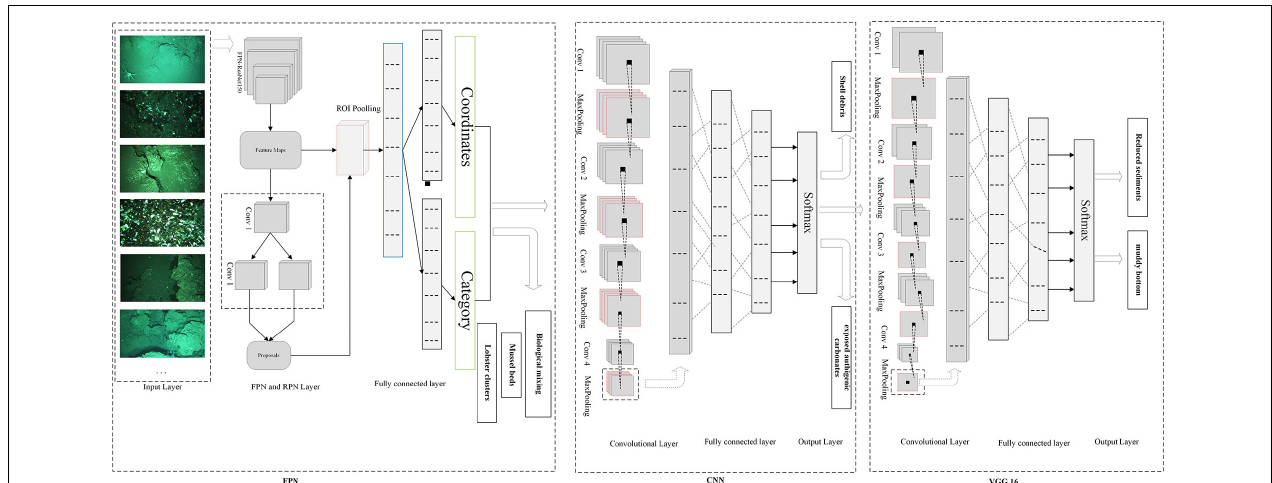
FIGURE 4 | Substrate classification model framework with the three classifiers of FPN, convolutional neural network (CNN), and VGG16 to identify the cold seep substrates.